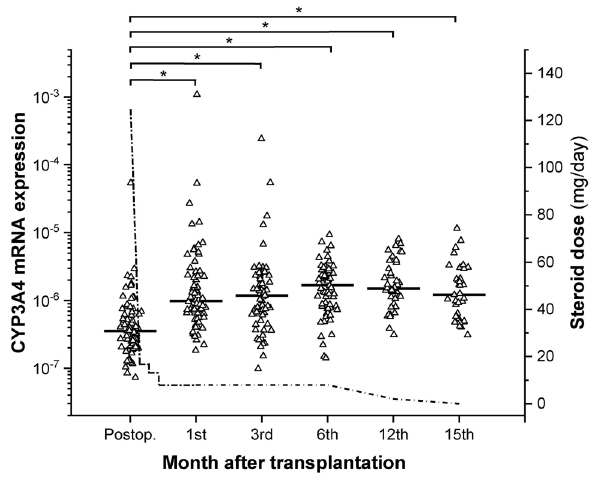
Figure 2. CYP3A4 mRNA expression in heart transplant recipients in a 15-month period after transplantation. The dotted line represents the daily dose of corticosteroid. *P <